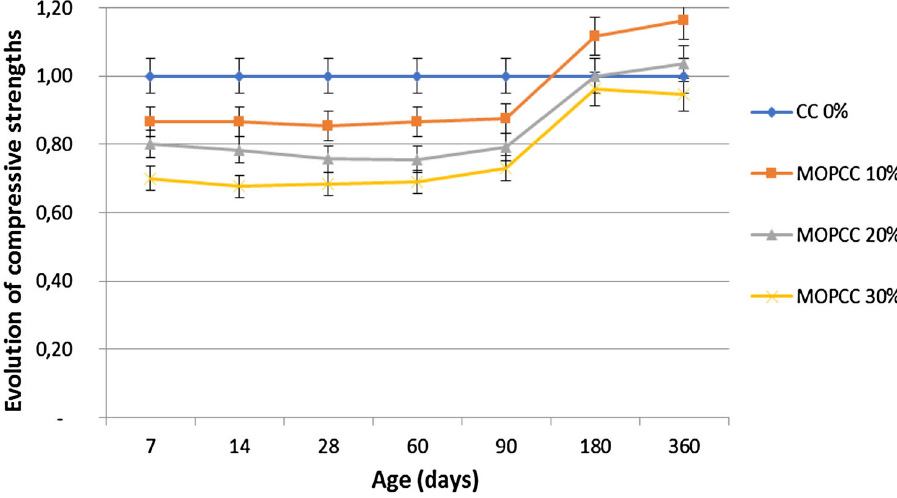
Fig. 9 Evolution of the strength of mud-based concretes with respect to control